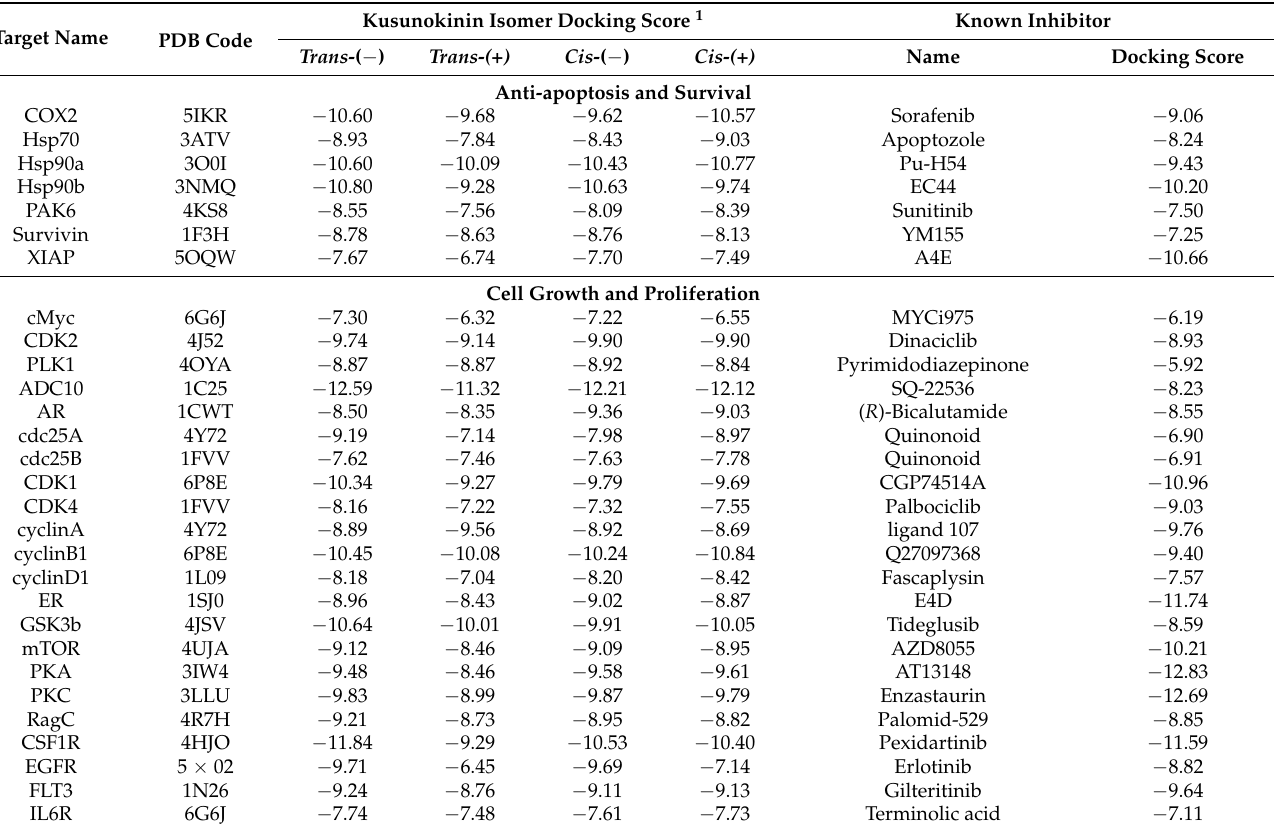
Table 1. The docking score of four possible kusunokinin isomers and inhibitors with 60 candidate